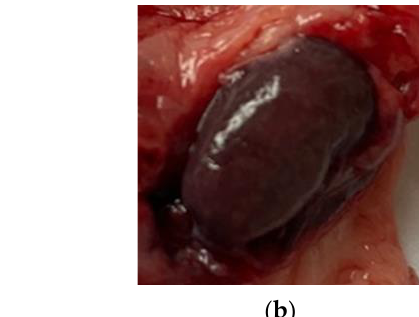
(Figure 2). Ten light and ten dark tissue samples from different individuals were used for histological examination.